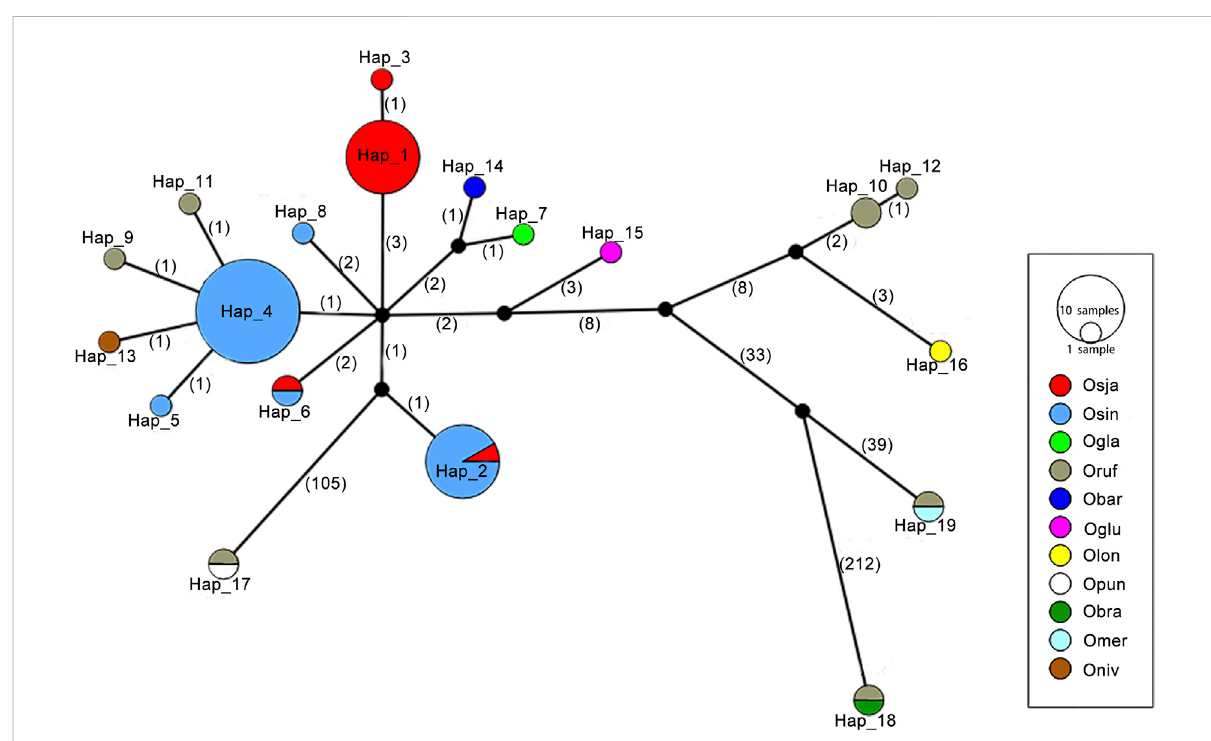
FIGURE 2 Ahaplotypenetwork basedon nucleotidepolymorphismsofthe Pi-d2 coding regionof66accessionsof11 Oryza species: O. sativa ssp. indica